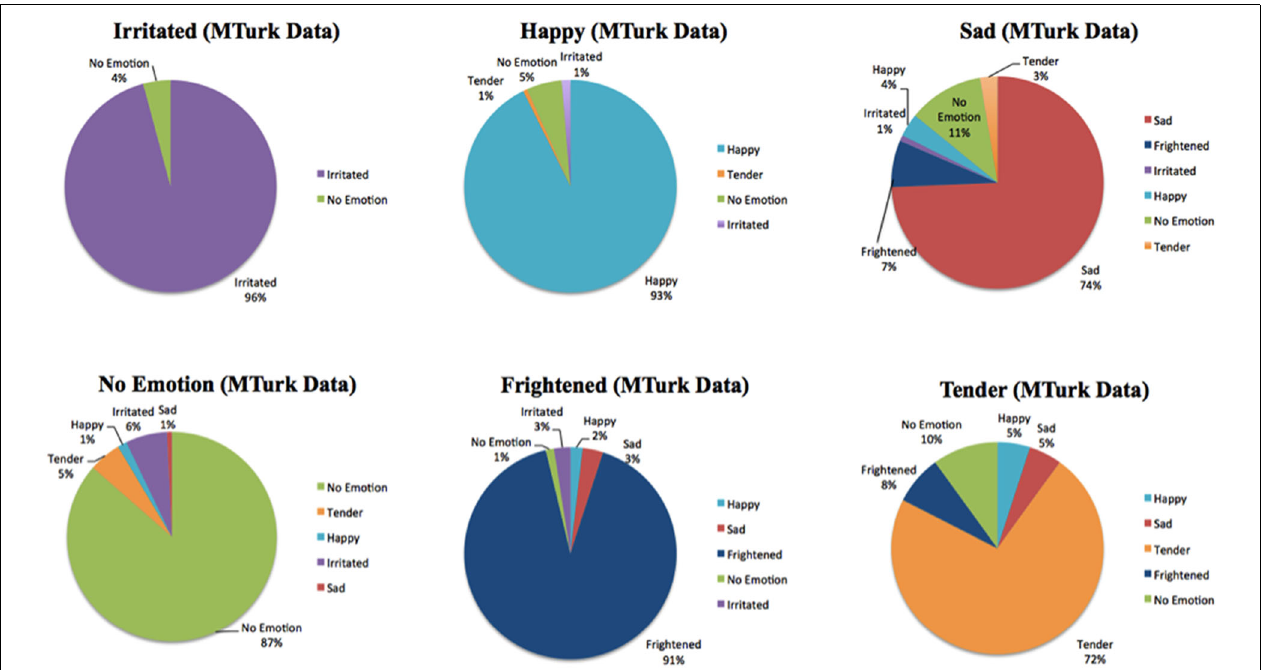
FIGURE 1 | Emotional identification results from Mechanical Turk listeners of MBEP speech